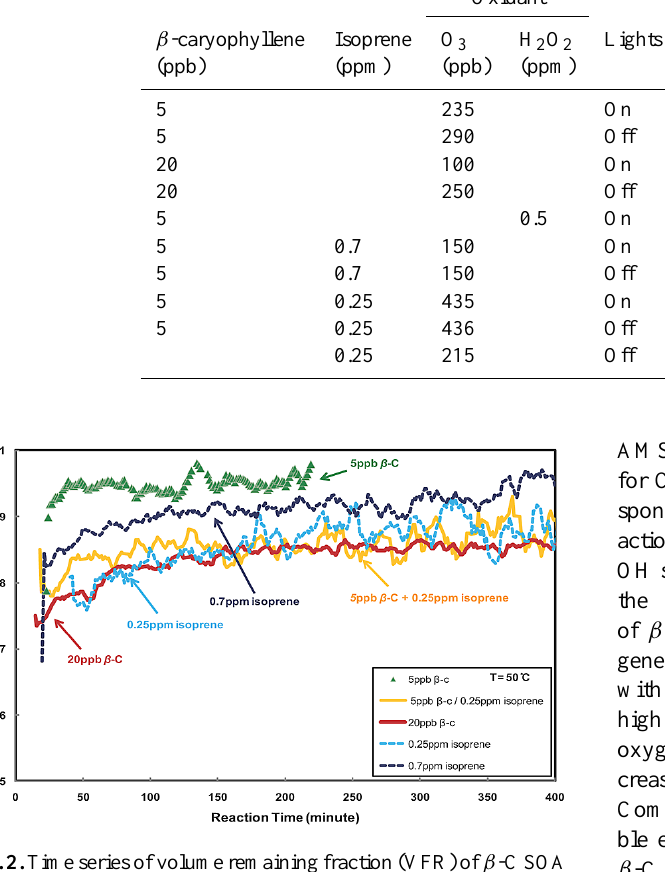
Fig. 2. Time series of volume remaining fraction (VFR) of β -C SOA and isoprene SOA at 50 ◦ C. There was no OH scavenger in all the experiments shown in the